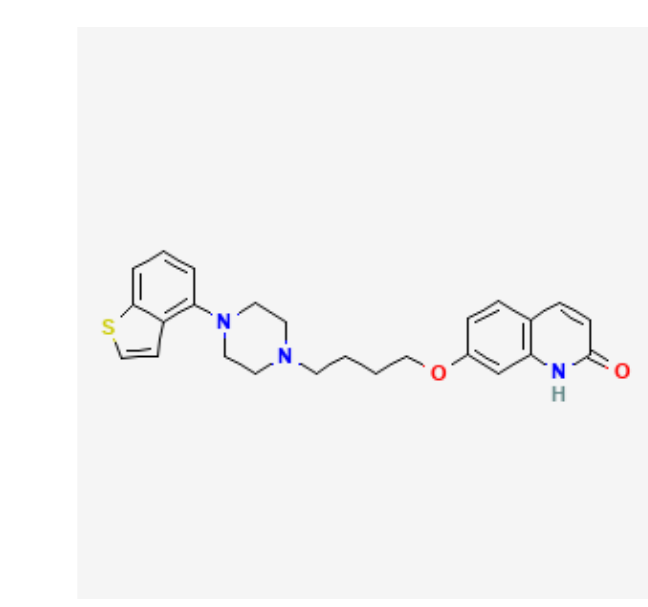
Figure 1. Brexpiprazole chemical structure based on [1].